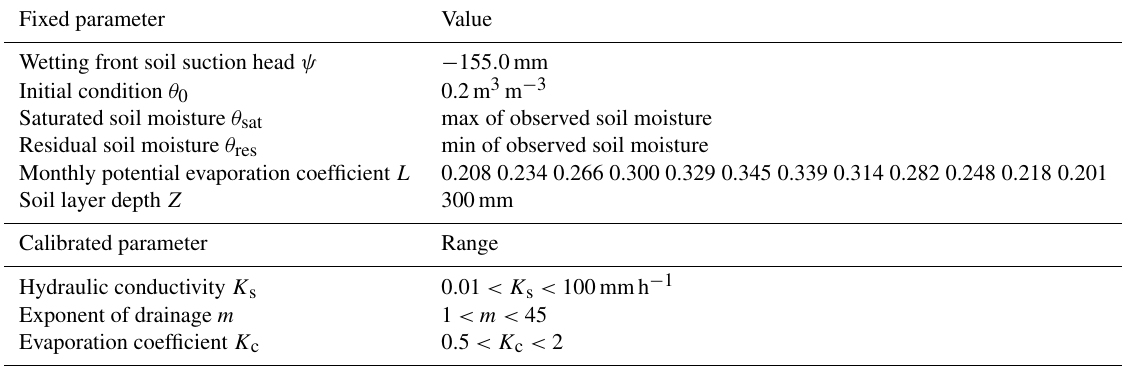
Table 2. Fixed parameter values and ranges of calibrated parameters of the soil moisture model. Fixed parameter L is calculated as the monthly percentage of the total daytime hours out of the total daytime hours of the